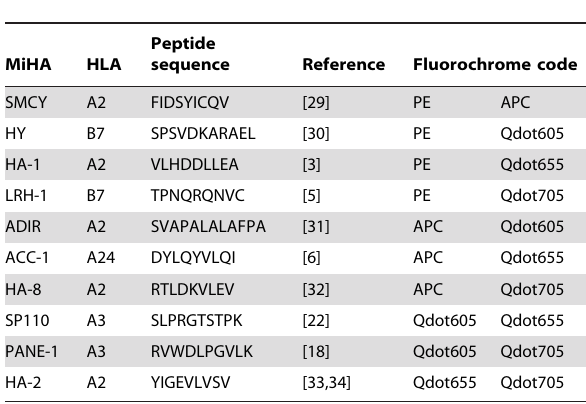
Table 1. MHC multimers and combinatorial encoding scheme as assembled in MiHA-multimer